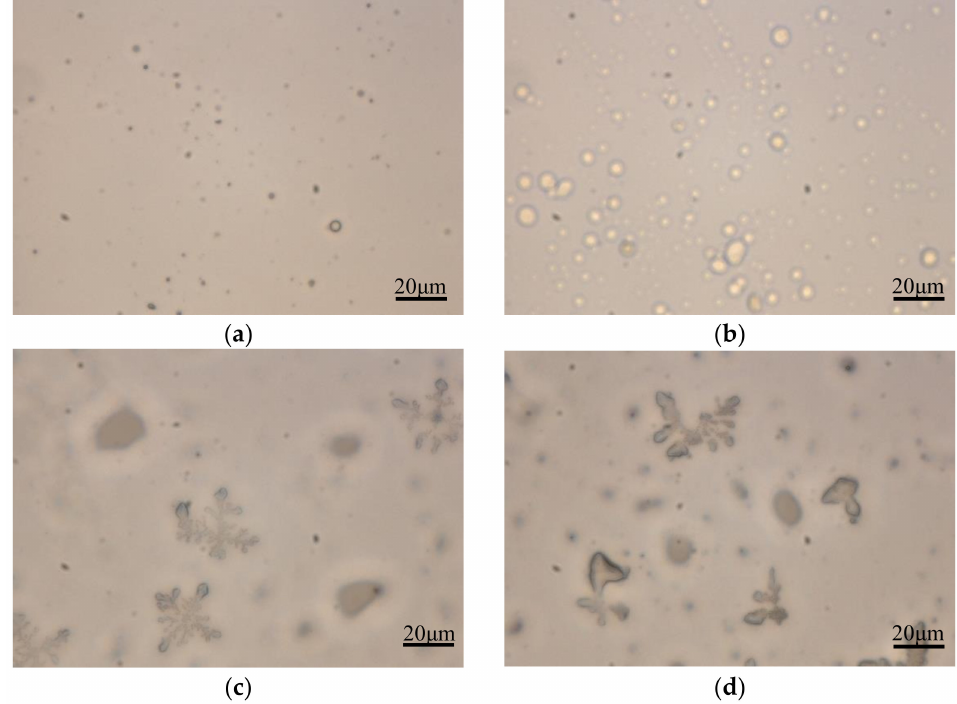
Figure 1. Polarized optical microscope photos of pure UF resin and UF resin with curing agent. ( a ) F/U = 1.4, ( b ) F/U = 1.0, ( c , d ) the effect of curing agent NH 4 Cl added 1 h on UF